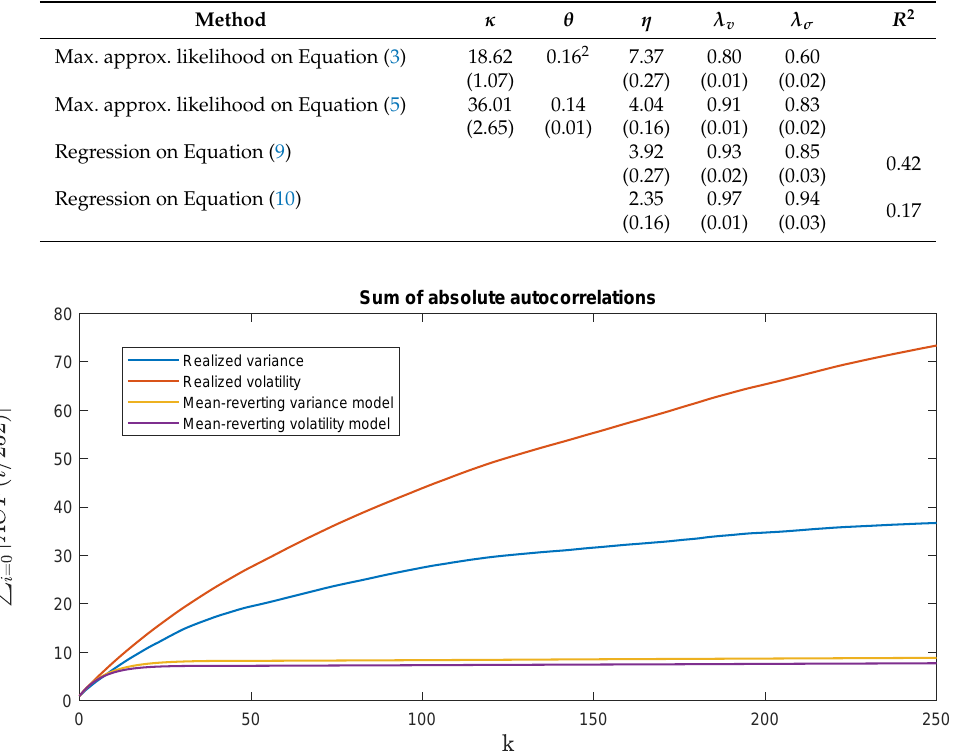
Figure 1. Cumulative sums of the empirical (absolute-value) autocorrelations. Blue and orange lines show the sums for the realized variance and volatility and that using the Oxford-Man dataset, respectively. The yellow and purple lines show the sums for the model (3) and (5), respectively. These values are computed in a simulation experiment using the parameters from Table 2. For these curves, the standard errors of each autocorrelation value were all less than